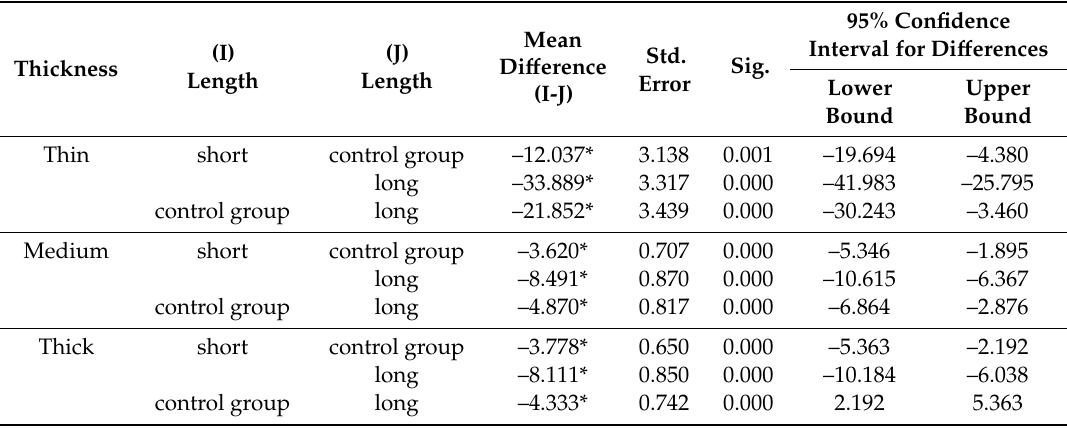
Table 2. Pairwise comparisons between stimuli with di ff erent lengths and thicknesses. Significant di ff erences are indicated by an asterisk (*).